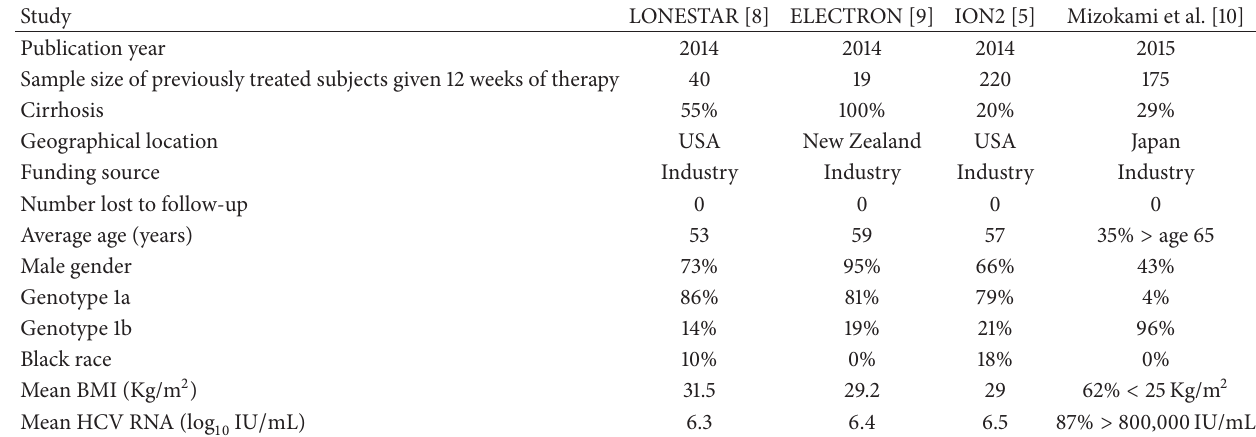
Table 1: Study characteristics of the previously treated subgroups within included studies.